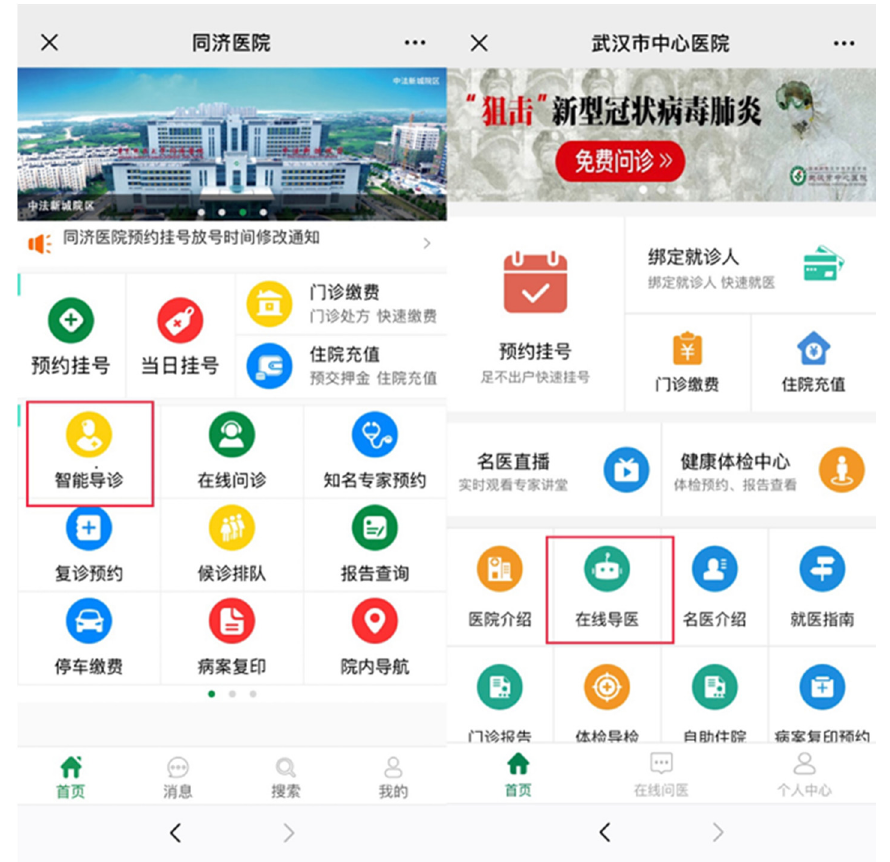
Figure 16. Community monitoring system page. [218]